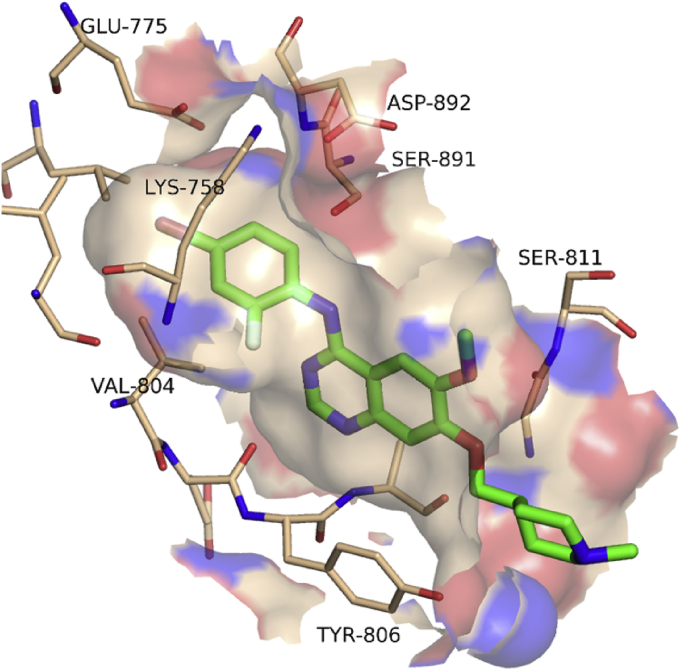
Location of key amino acids within the ATP-binding site of RET, illustrated using the X-ray structure of vandetanib (PDB code 2IVU). Amino acids that differ between RET and KDR include Ser891 (KDR Cys1045), Ser811 (KDR Asn923) and Tyr806 (KDR Phe918). Figure prepared using the Pymol Molecular Graphics System (Schrödinger, LLC, New York, NY).